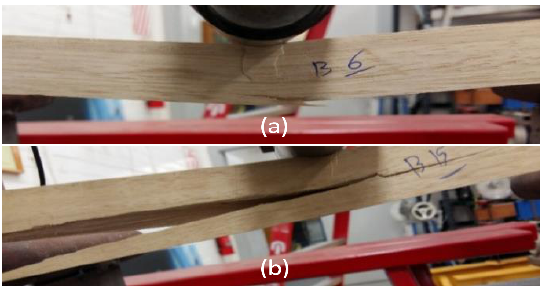
Figure 4. The most frequently observed failure modes of the bending test samples. Combined compression and bending tension failure ( a ) and grain tension failure ( b ).